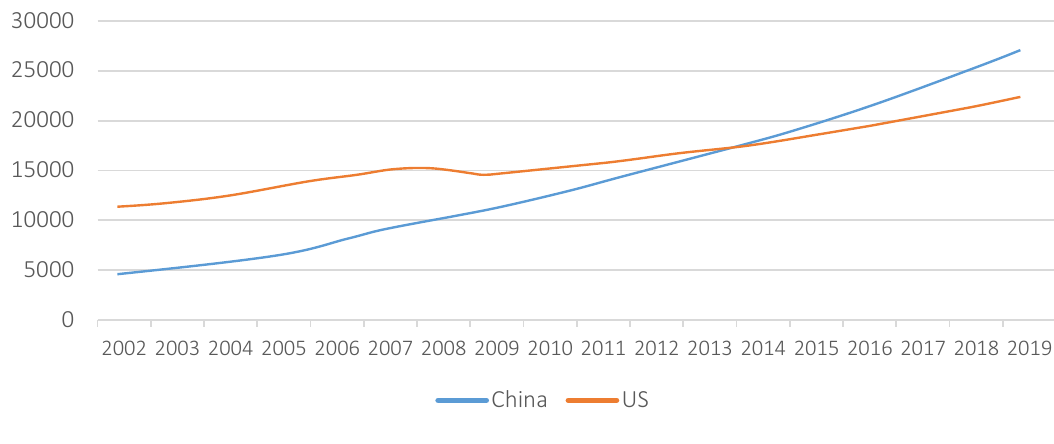
Figure 1. In PPP terms, the economy of China has surpassed the economy of the USA